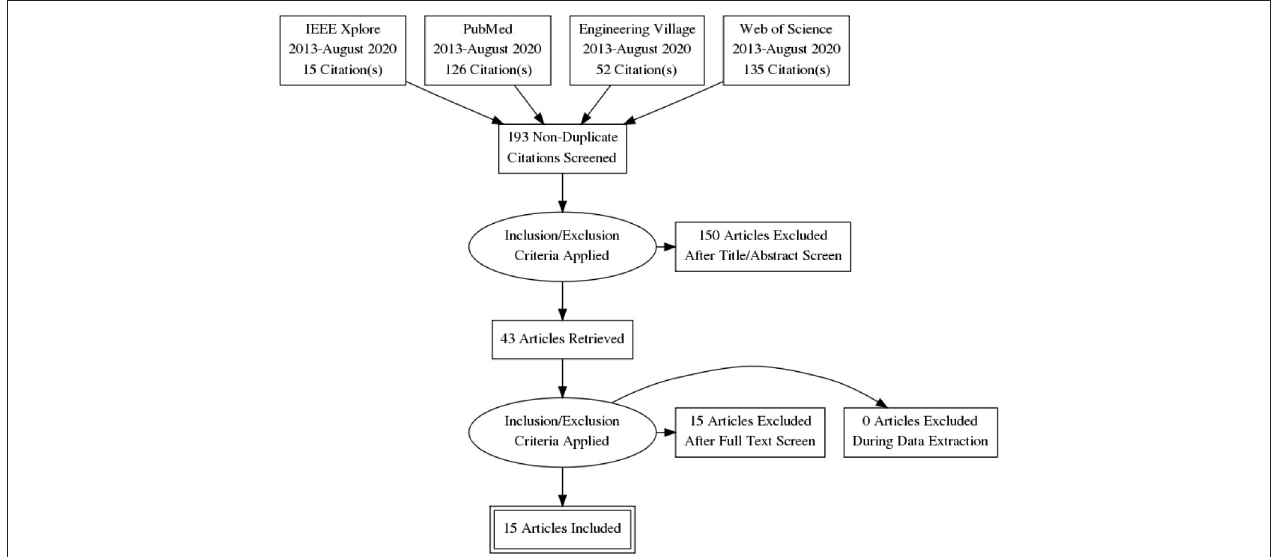
FIGURE 3 | PRISMA flow diagram of brain-to-brain interface research paper